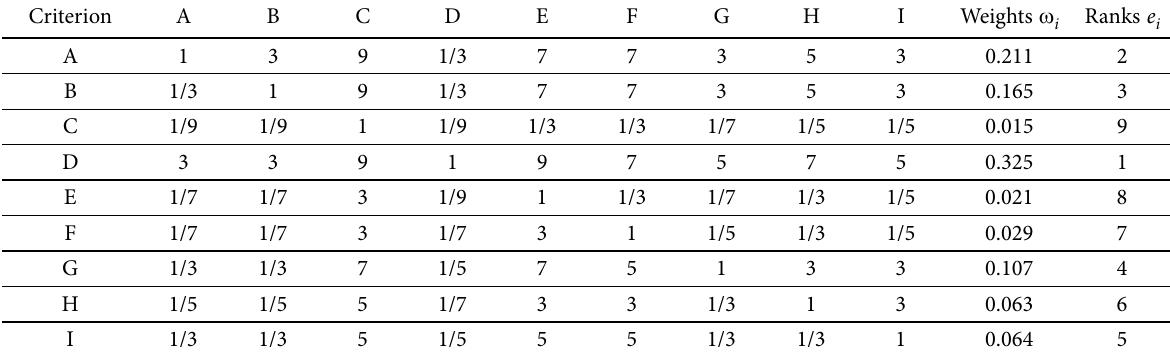
Table 3. Data on comparing the criteria elicited from expert